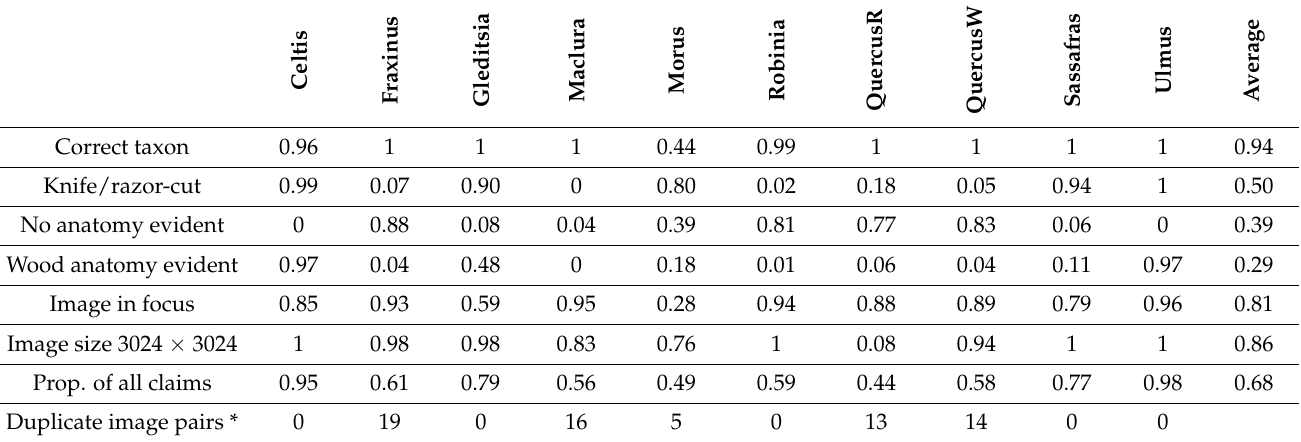
Table 2. The class-wise and average proportion of claims about LD-train images. For the claims “Knife/razor cut”, “No anatomy evident”, “Wood anatomy evident”, and “Image in focus”, the proportions are calculated only for images that are consistent with the class. “Prop. of claims” excludes the “No Anatomy Evident” claim. * The entries in the “Duplicate image pairs” row are counts.